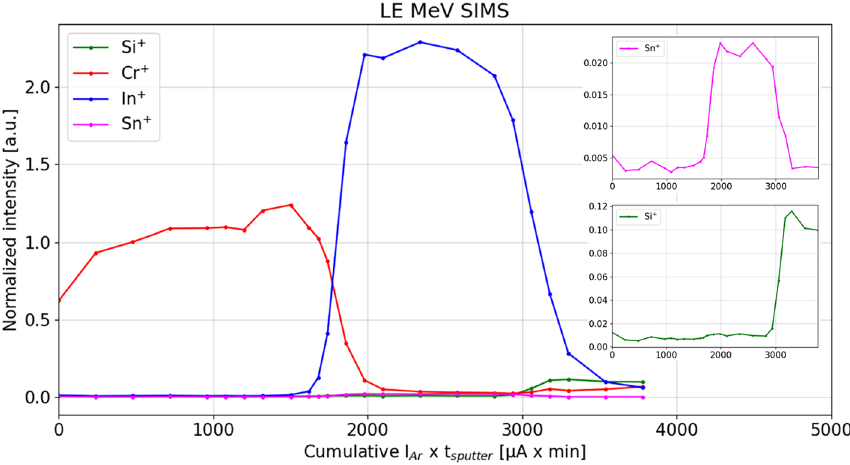
Figure 3. LE MeV SIMS depth profile of detected positive secondary ions from inorganic species from dual- layer Cr-ITO sample on a soda-lime glass. Low intensity ions are presented inside the plot: Sn + (top) and Si +